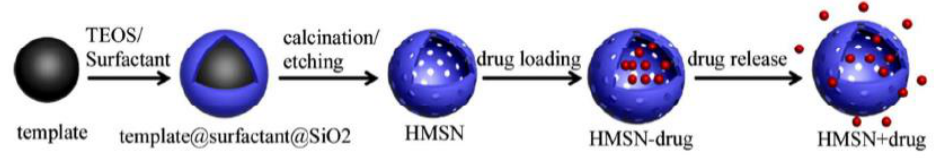
Figure 15. Schematic illustration of preparation of hollow mesoporous silica nanoparticles (HMSN) and drug loading-release. Reprinted with permission from [188]. Copyright 2017 Royal Society of Chemistry.